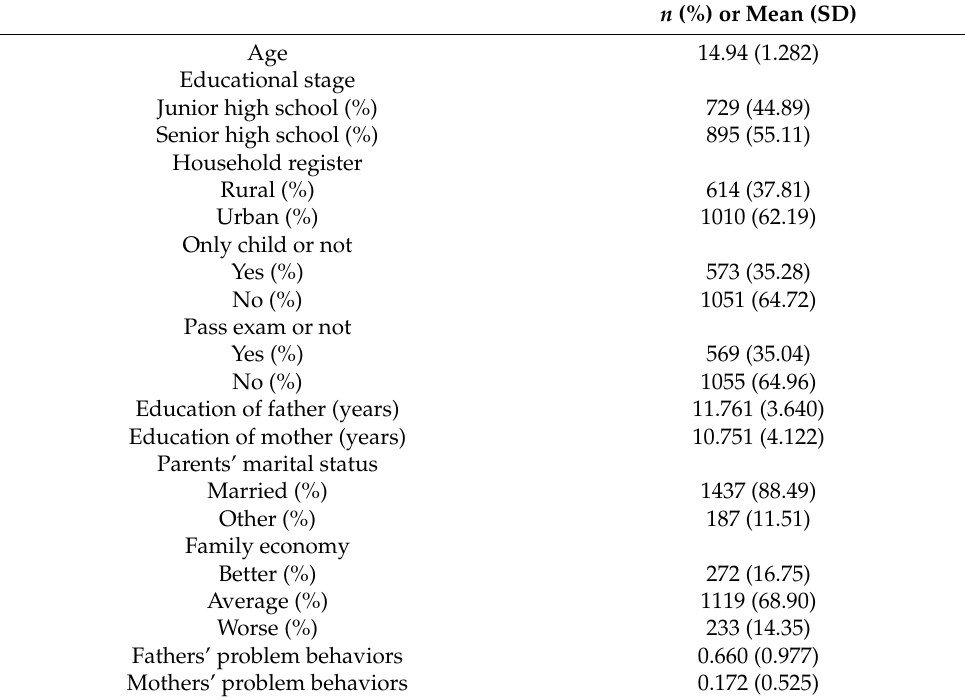
Table 1. Description of sociodemographic characteristics of the male adolescent sample ( n = 1624).